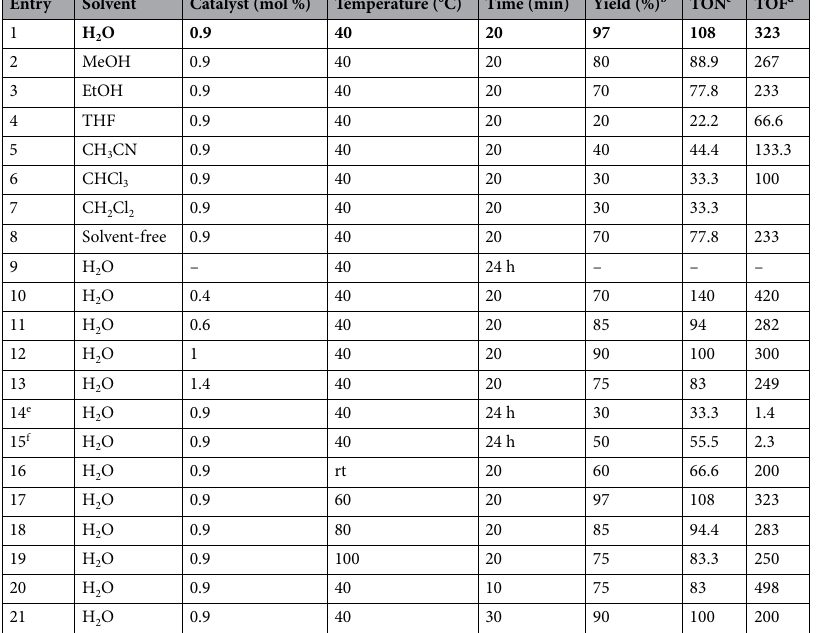
Table 3. Optimization of the reaction conditions for the synthesis of 5-aryl 1 H - tetrazole derivatives a . Significant values are in bold. a Benzaldehyde (1.0 mmol), hydroxy amine hydrochloride (1.0 mmol), Sodium azide (1.2 mmol) and Fe 3 O 4 @SiO 2 -Im[Br]-SB-Cu (II) (0.9 mol%, 0.012 g). b Isolated Yield. c Turnover numbers (TONs) defined as mmol of transformed substrate molecules per mmol of catalyst. d Turnover frequencies (TOFs) defined as mmol of substrate molecules transformed per mmol of catalyst per hour. e Fe 3 O 4 (0.012 gr). f